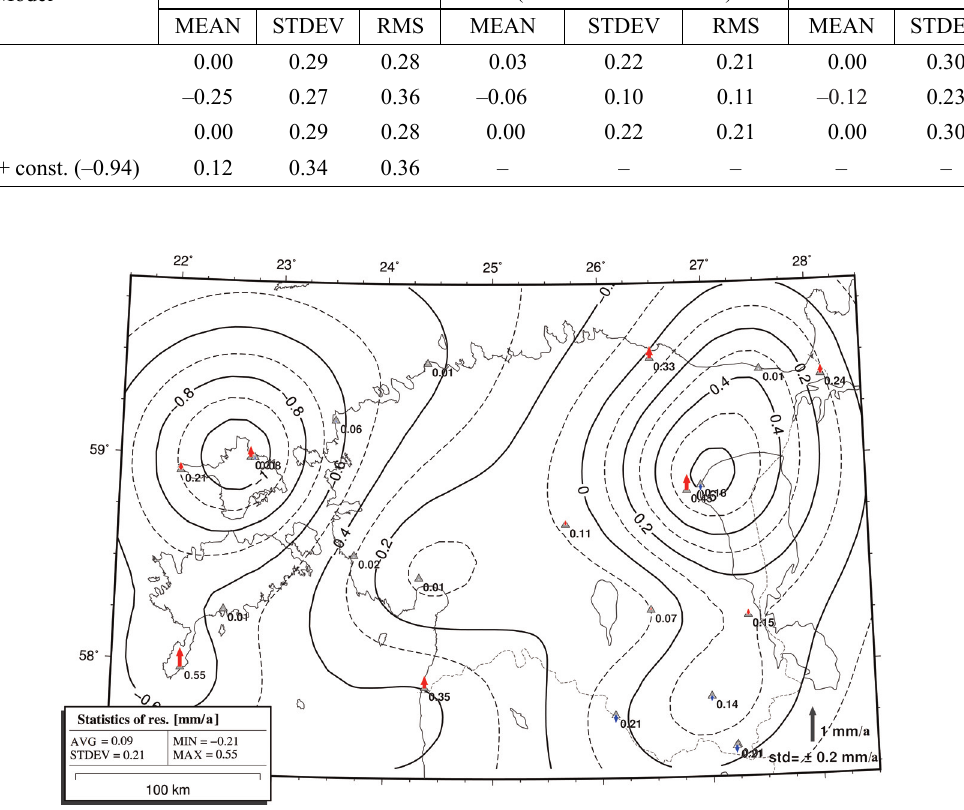
Fig. 9. Least squares collocation model for residual velocities (red arrows) of the Up component. Note ‘bull’s-eyes’ around data points (triangles), due to the lack of autocorrelation between